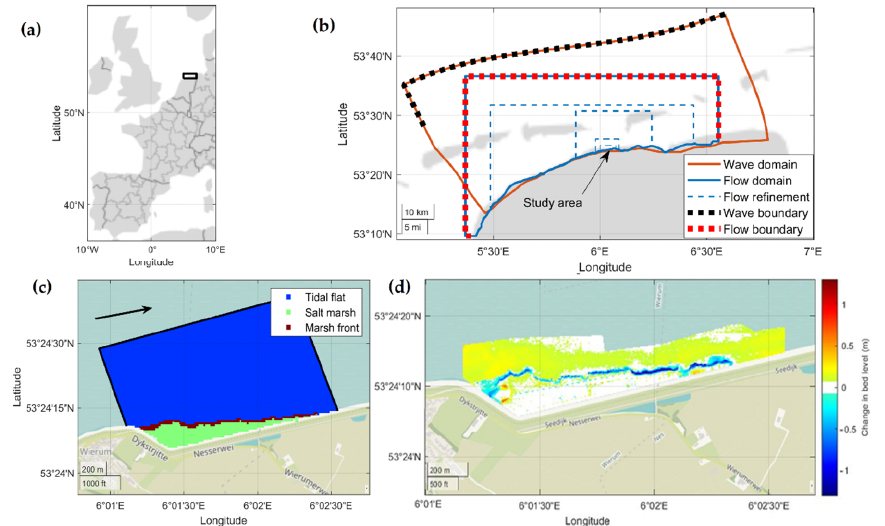
Figure 1. ( a ) The study area’s location within Europe. ( b ) The area of the model domains and their main characteristics. The arrow indicates the location of the study area, which is the salt marsh near Wierum, the Netherlands. ( c ) The location of the tidal flat, salt marsh, and marsh front within the study area. The marsh front is also part of the salt marsh itself. The arrow indicates the dominant direction of tidal flow and alongshore transport. ( d ) Observed bed level change between the spring of 2008 and the spring of 2014 [22]. The erosion in dark blue displays the erosion of the marsh edge. Tides in the area are predominantly semi-diurnal with an averaged amplitude of 1.1 (cid:1865) . The amplitude of a spring-neap cycle, on top of the average amplitude, is 0.35 (cid:1865) . Local flow velocities of up to 1.2 (cid:1865)/(cid:1871) are observed [23]. In this paper, the month of October 2017 is simulated which contains